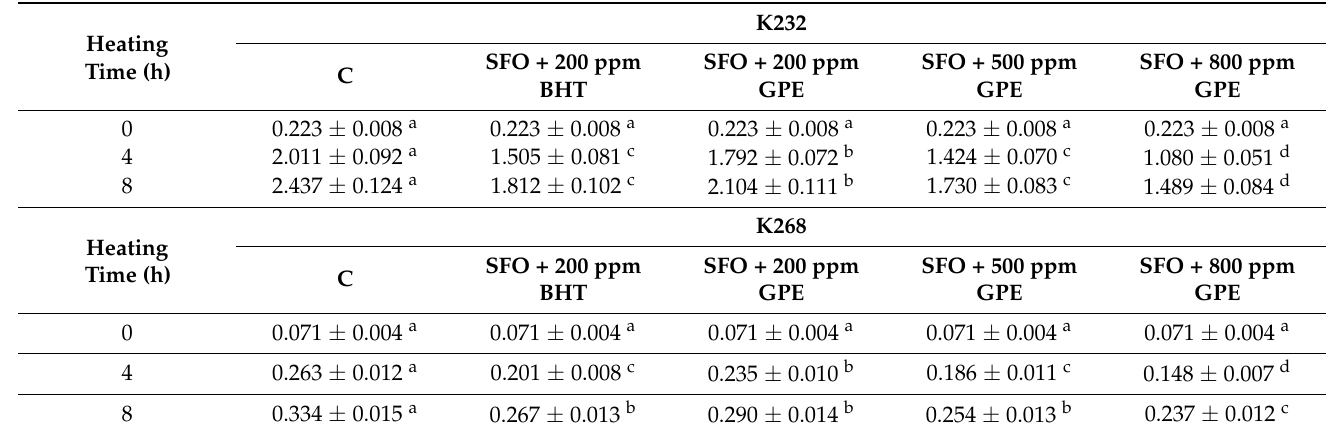
Table 5. Changes recorded in K232 and K268 values of sunflower oil (SFO) samples with the addition of GPE and BHT during convective heat exposure, compared to the control sample